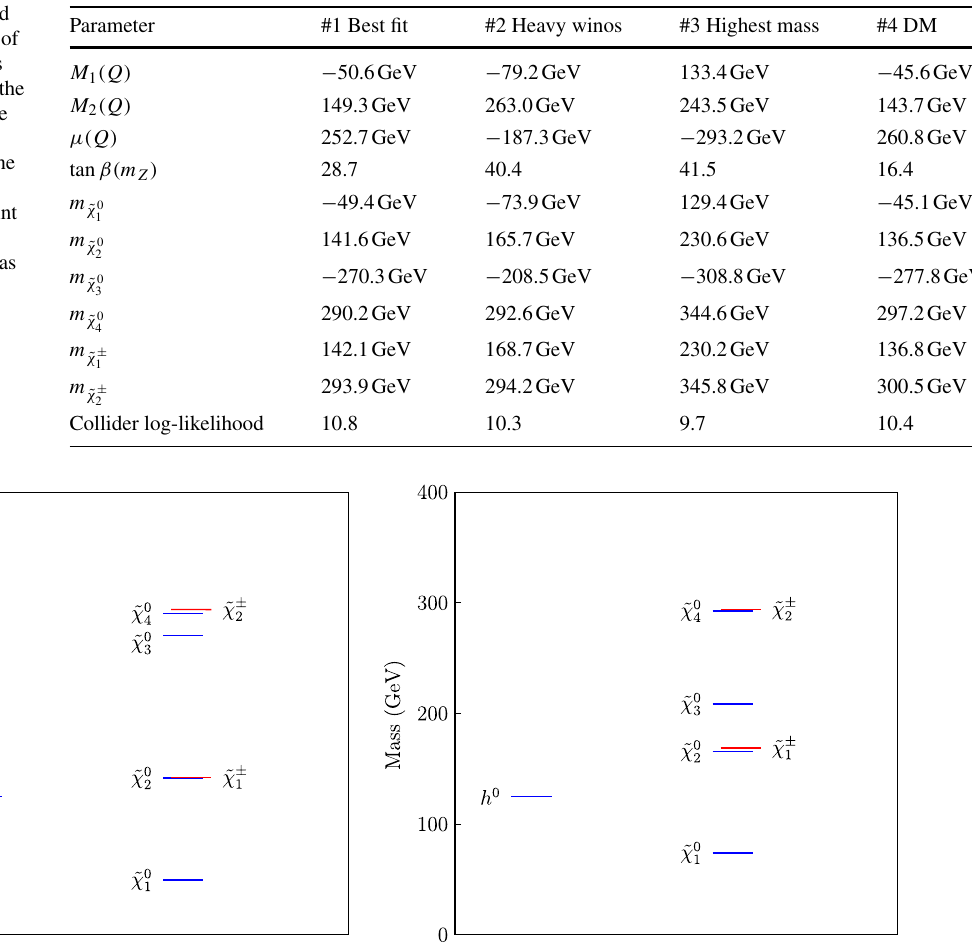
fit signal. The total significance is dominated by contribu- tions from the ATLAS_4lep and ATLAS_RJ_3lep analyses, whilst other analyses do not disfavour this